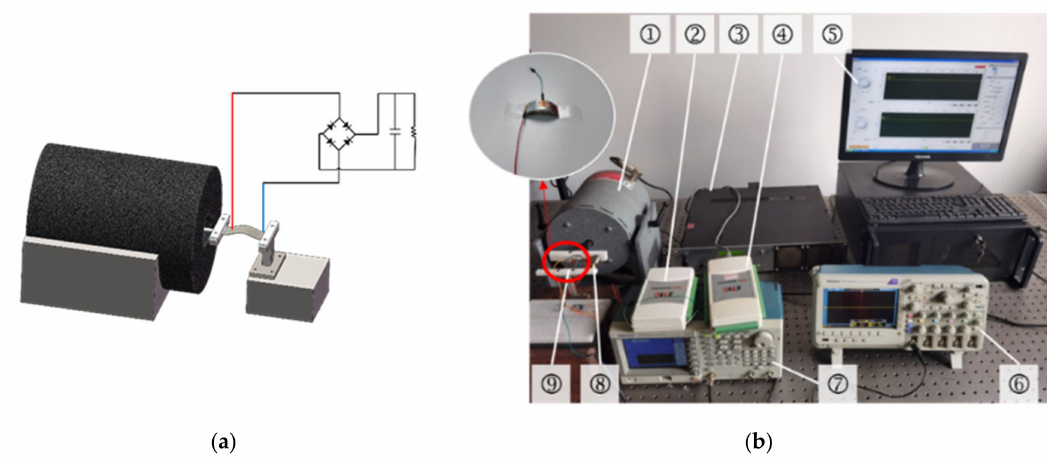
Figure 14. ( a ) a 3D model of the doubly clamped PEH; ( b ) measurement system of the doubly clamped energy harvester, in which 1 (cid:13) is the vibrating shaker, 2 (cid:13) is the signal conditioner, 3 (cid:13) is power amplifier, 4 (cid:13) is the data acquisition